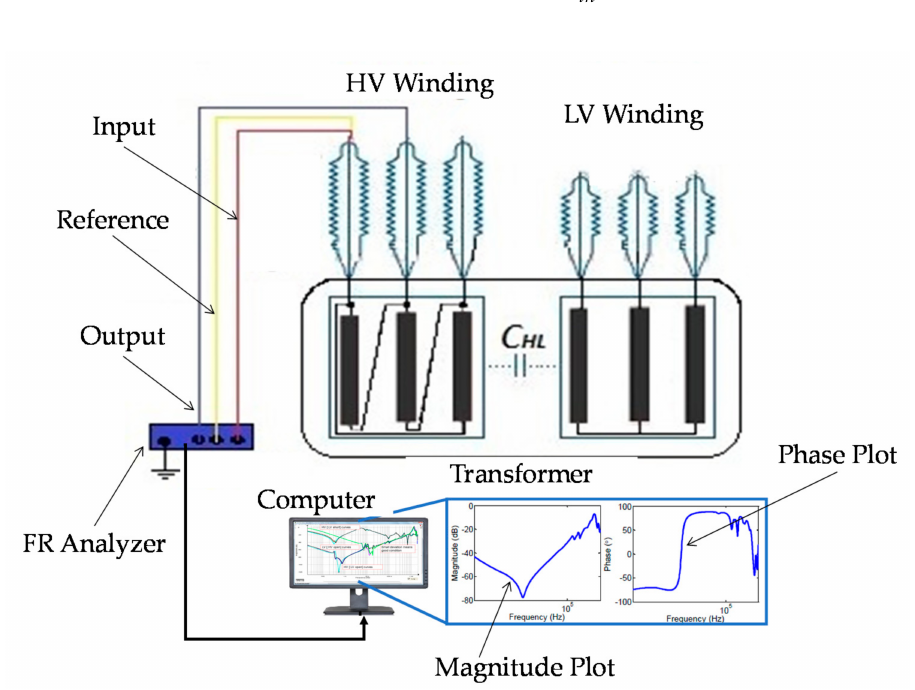
Figure 2. FRA test setup for transformer winding at end-to-end open circuit test